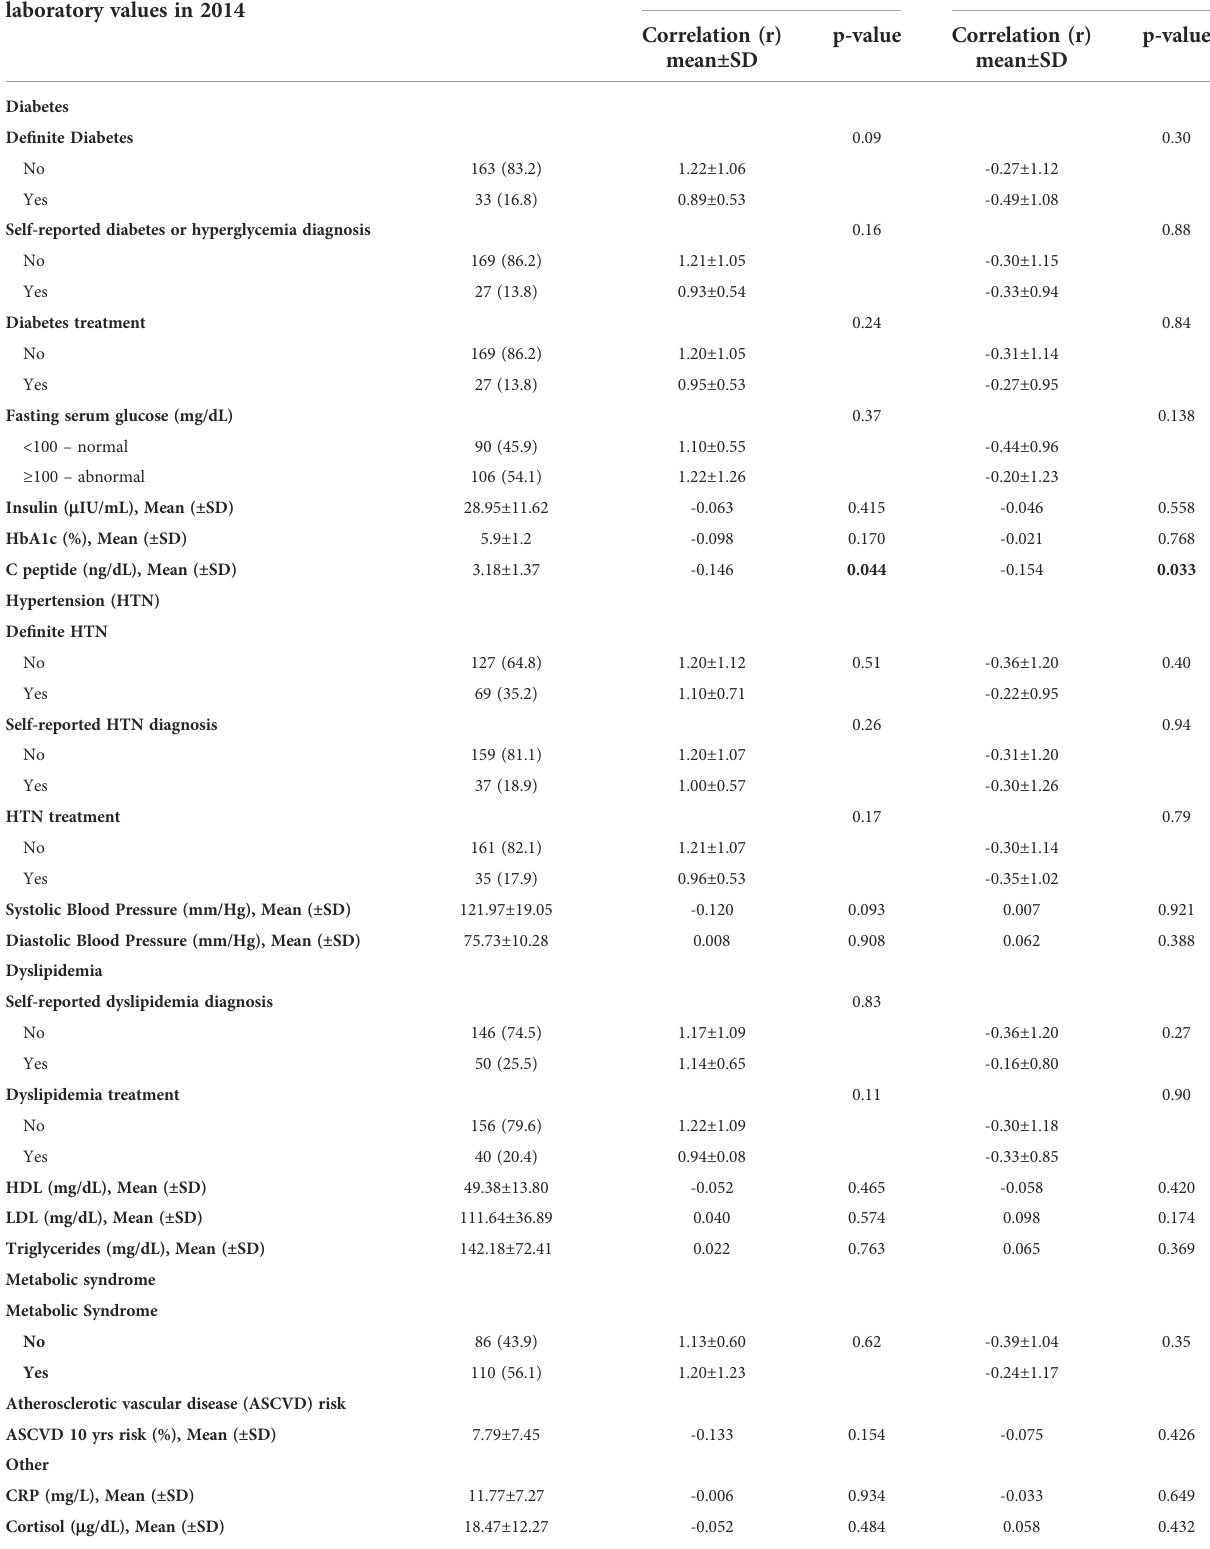
TABLE 2 Association of cardiometabolic risk factors and laboratory values in 2014 with RTL at follow up in 2019 and D RTL. Cardiometabolic risk factors and laboratory values in